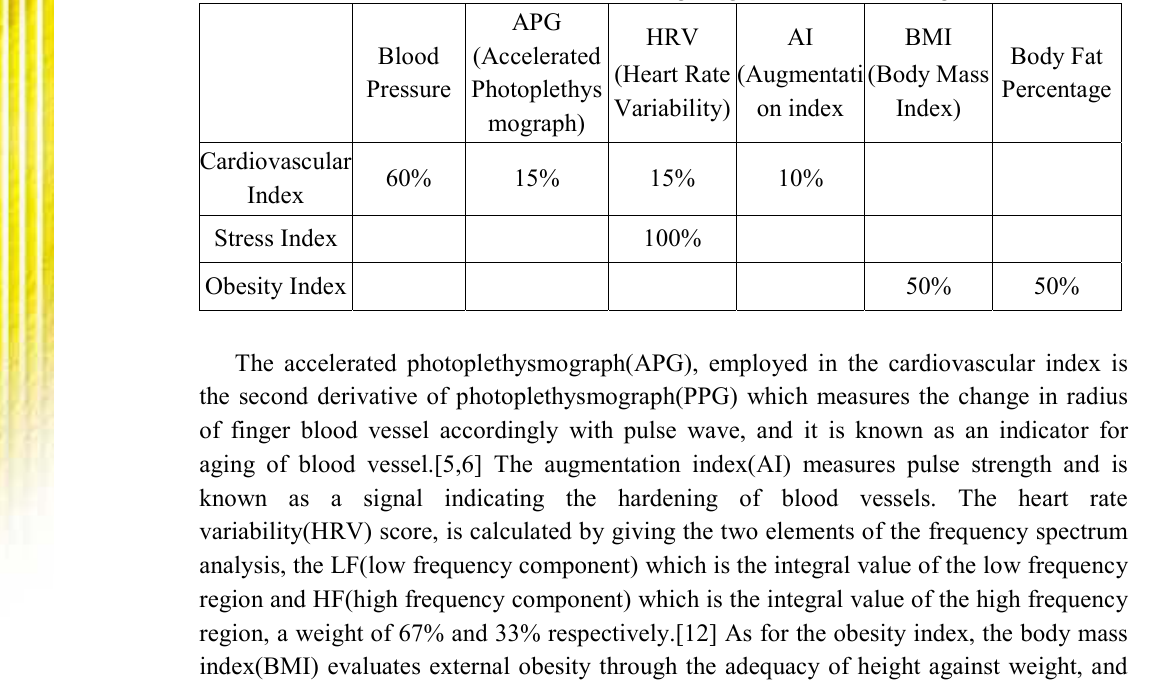
Table 1 Measurement information and weighting factor for estimating health index